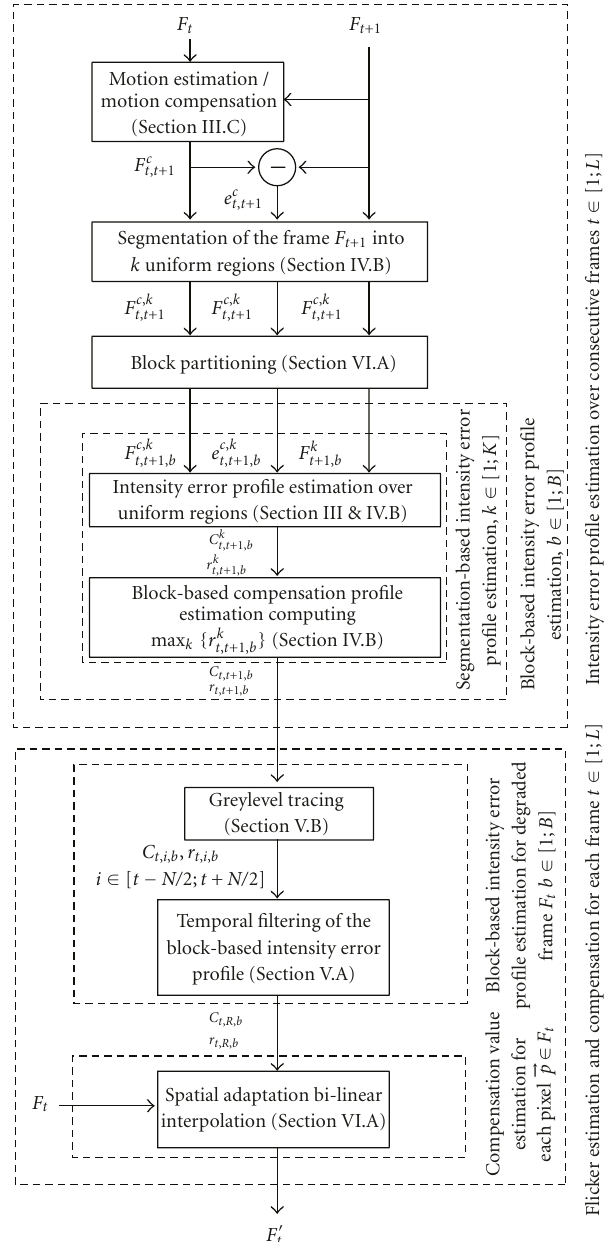
Figure 10: Flow chart of the proposed compensation algorithm. The algorithms operates in two stages: intensity error profile over consecutive frames are first computed on a block-based basis. Afterwards these profiles are employed to calculate block-based compensation profiles related to a specific degraded frame, which are finally bi-linearly interpolated to obtained pixels compensation values.